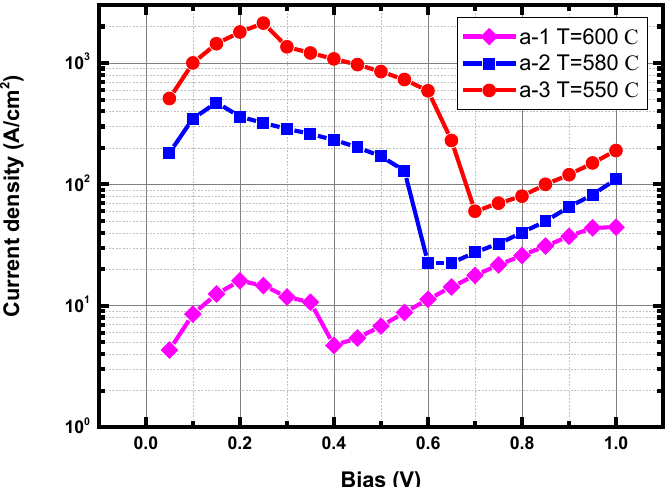
Figure 4. Experimental results of tunnel-junction devices under various growth temperature of the In 0.07 GaAs layer.